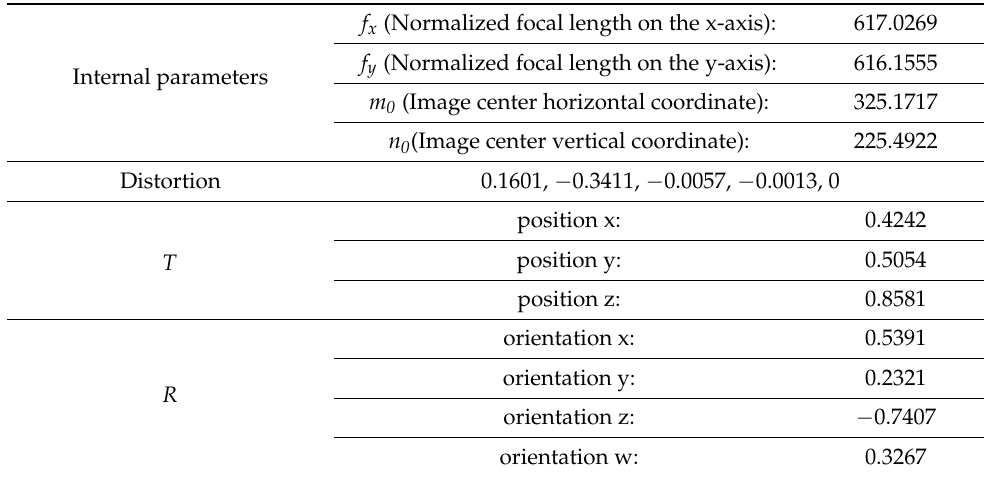
Figure 18. Eye-to-hand calibration process. Table 4. Calibration